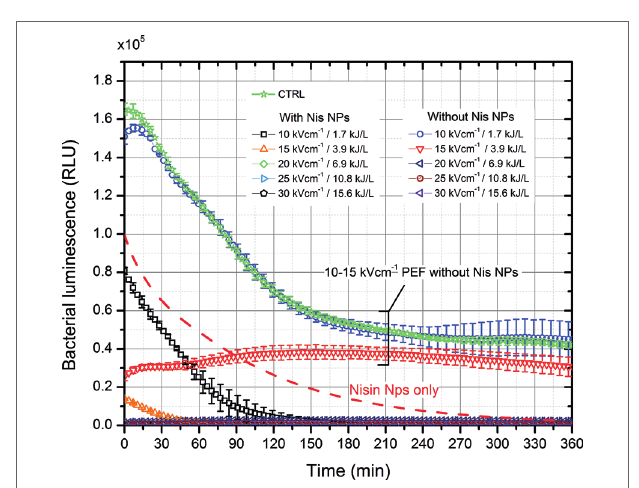
FIGURE 4 | The dependence of bacteria luminescence on the applied combined pulsed electric field (100 μs × 8) and nisin nanoparticles (0.2 mg/ml)